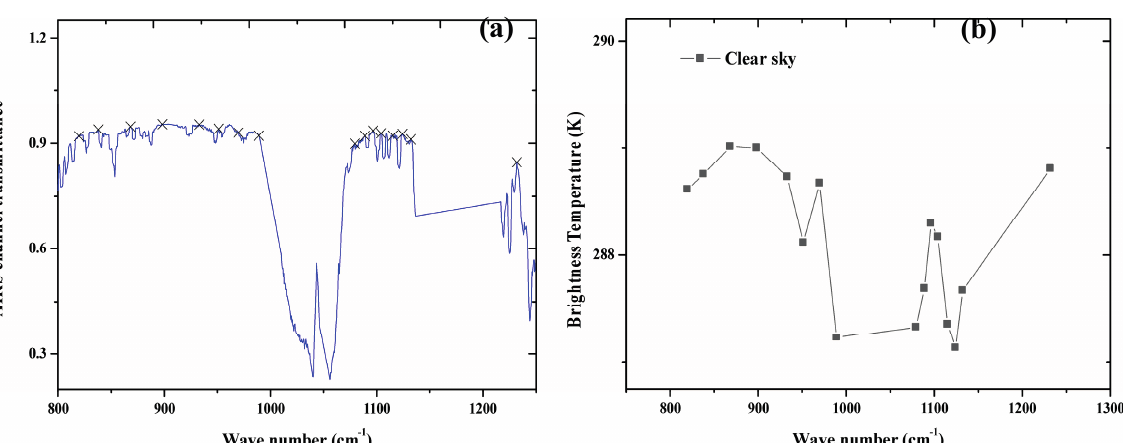
Figure 2. ( a) The simulated nadir-viewed AIRS channel transmittances (blue line) under the condition of clear sky, and the selected dust observation channels (black cross) in the region of 800–1250 cm − 1 . ( b ) The simulated nadir-viewed spectral brightness temperatures of selected AIRS channels under the condition of clear sky.